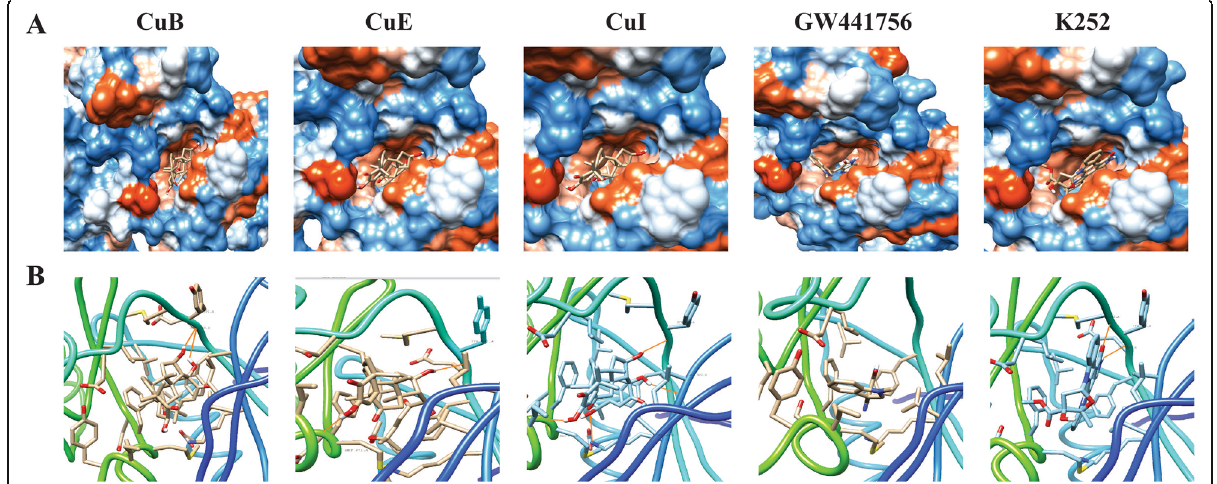
Fig. 2 Two binding modes of Cucurbitacins in the tropomyosin receptor kinase A (TrkA) binding site. ( a ) The molecular surface of TrkA colored according to the electrostatic potential. ( b ) Closer view of the docking model of Cucurbitacins and TrkA. Hydrogen-bonding interactions are shown as orange lines and the hydrogen-bonding interactions of the amino acids stabilize the complex